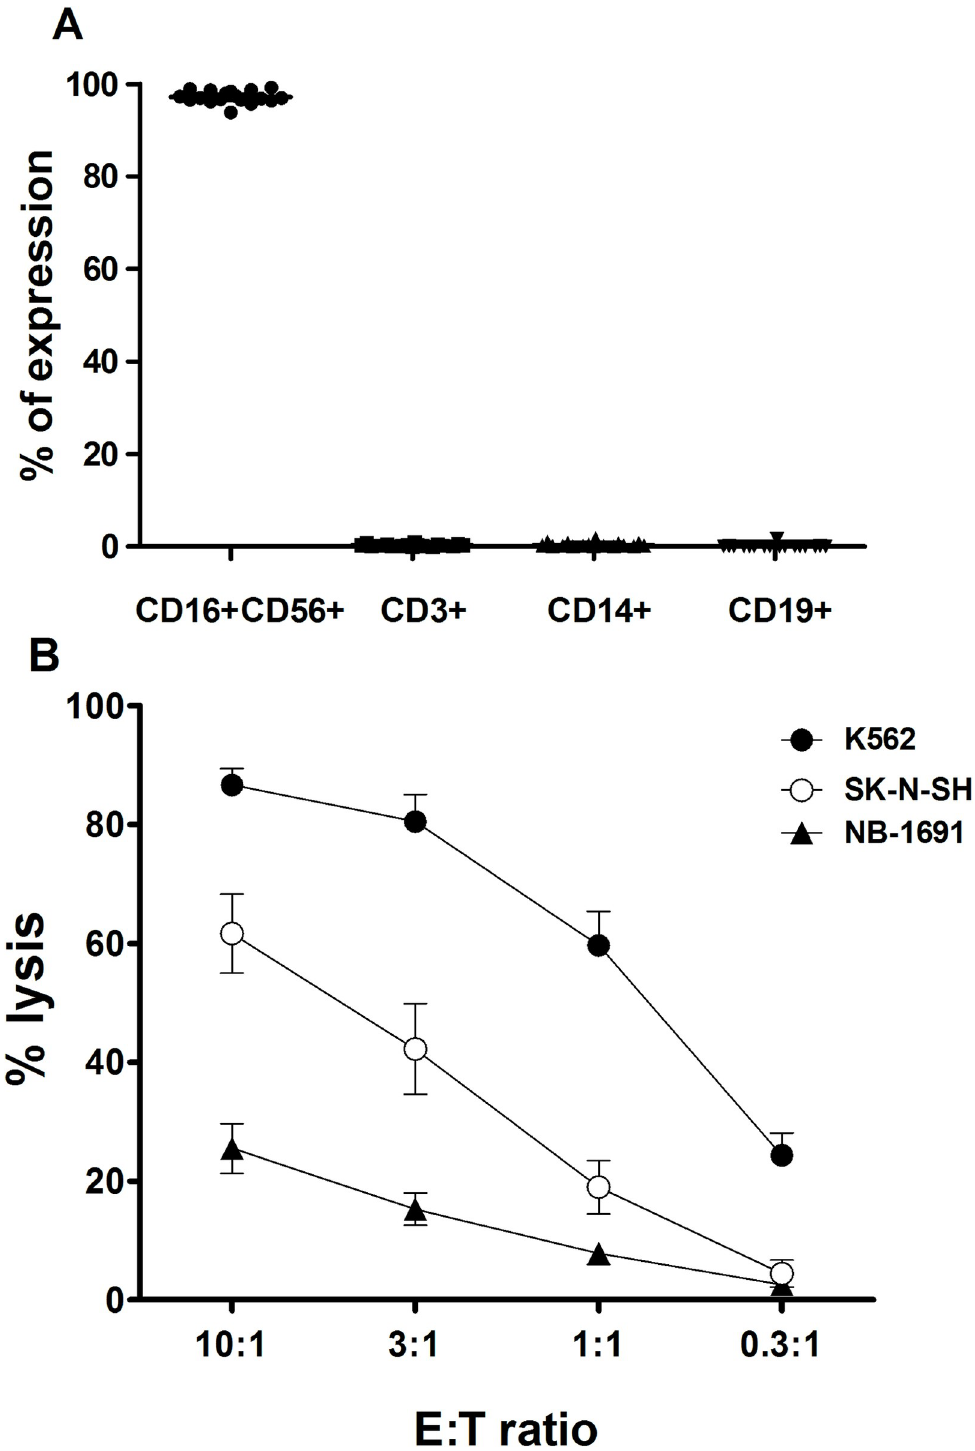
Fig 1. Characterization of ex vivo -expanded NK cells. (A) The percentages of CD16 + CD56 + , CD3 + , CD14 + , and CD19 + cells were analyzed by flow cytometric analyses. (B) Cytotoxicity of expanded NK cells against the K562, SK-N-SH, and NB-1691 cell line was analyzed by calcein releasing assay with the indicated E:T ratio. Each point represents mean ± SD.